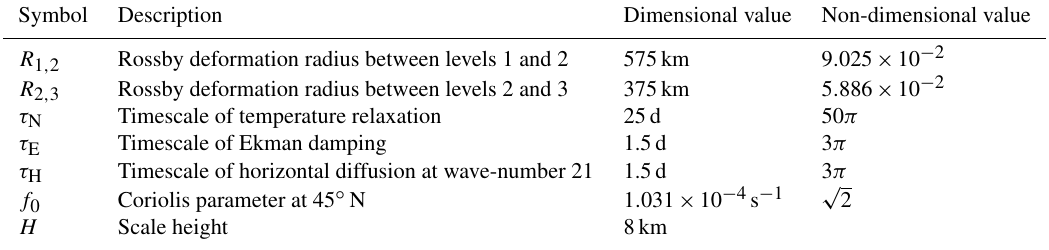
Table 2. Parameters in the QG model.